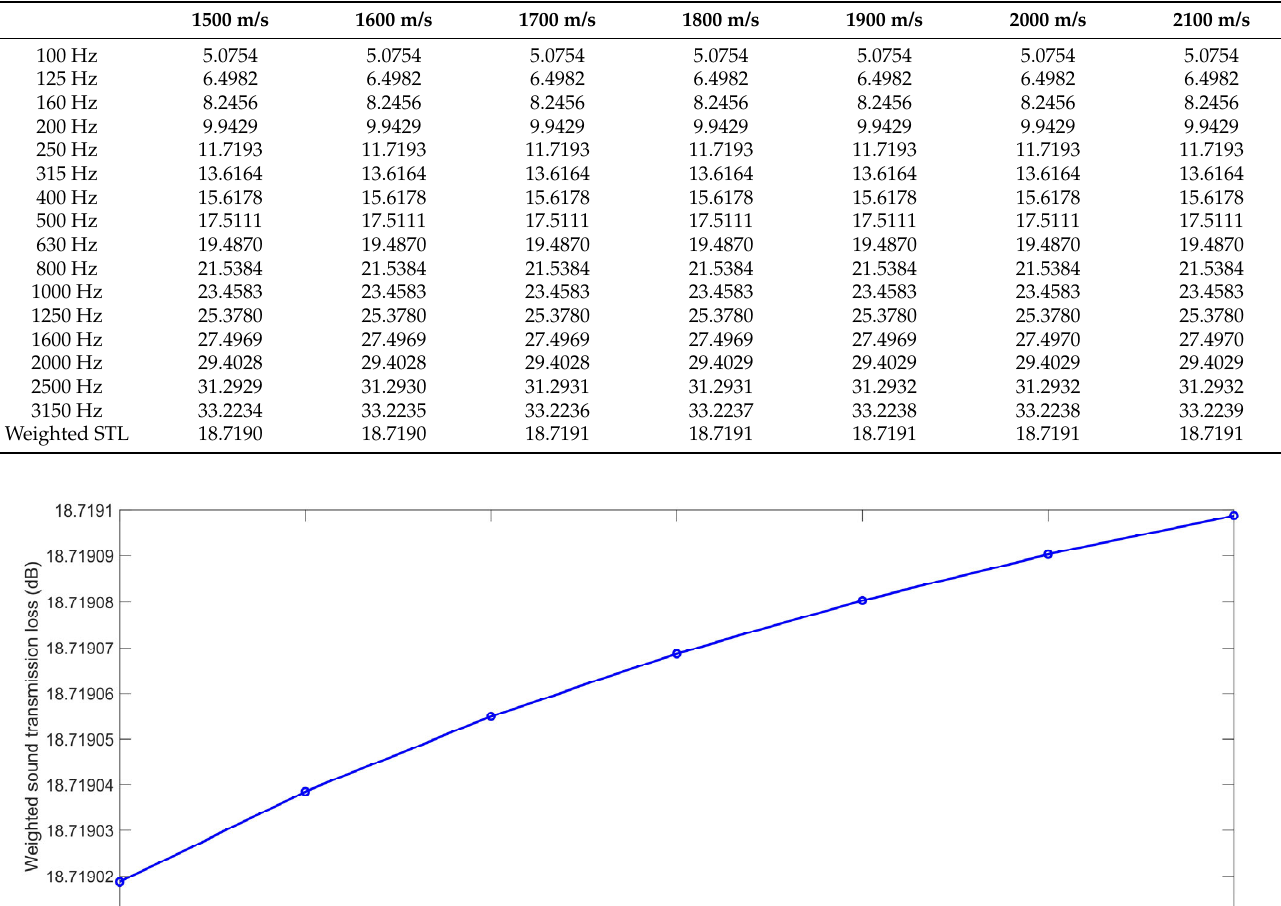
Table 9. The summarized STL data with the various acoustic velocity in the composite rubber.